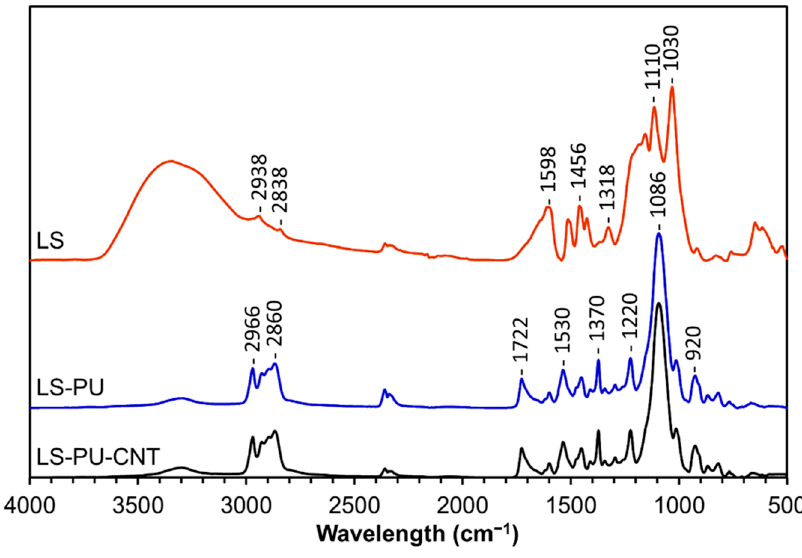
Figure 1. FTIR-ATR spectra of LS, LS-based PU (LS-PU), and LS-based PU doped with 1% w / w MWCNTs (LS-PU-CNT).